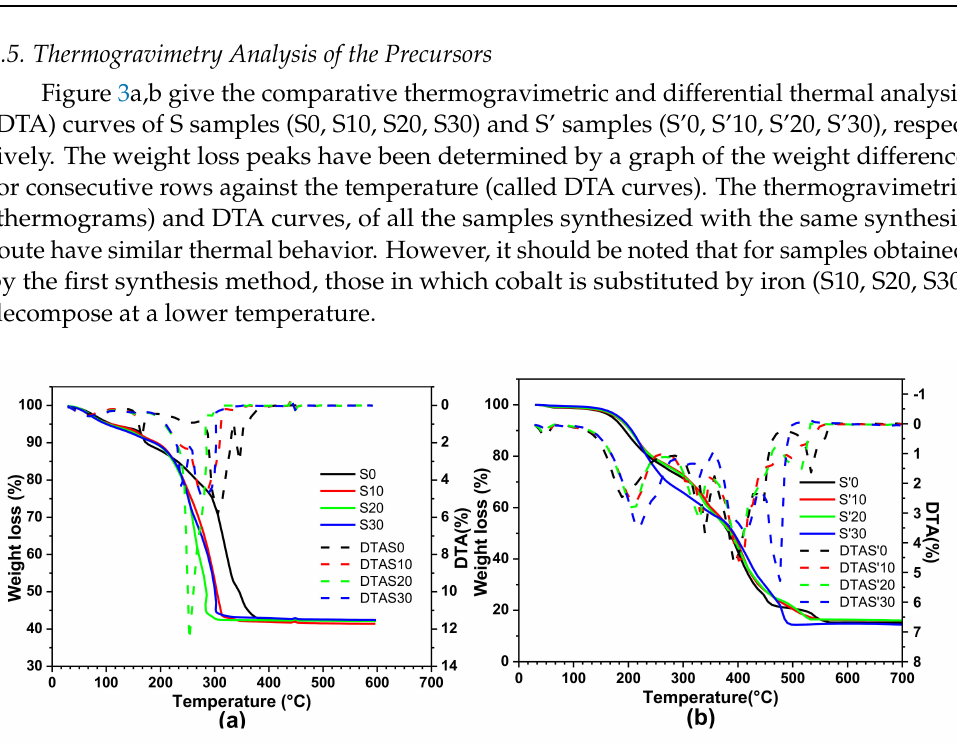
Figure 3. Thermogravimetric analysis (TGA) and differential thermal analysis (DTA) curves for samples ( a ) S0, S10, S20, S30; ( b ) S’0, S’10, S’20,